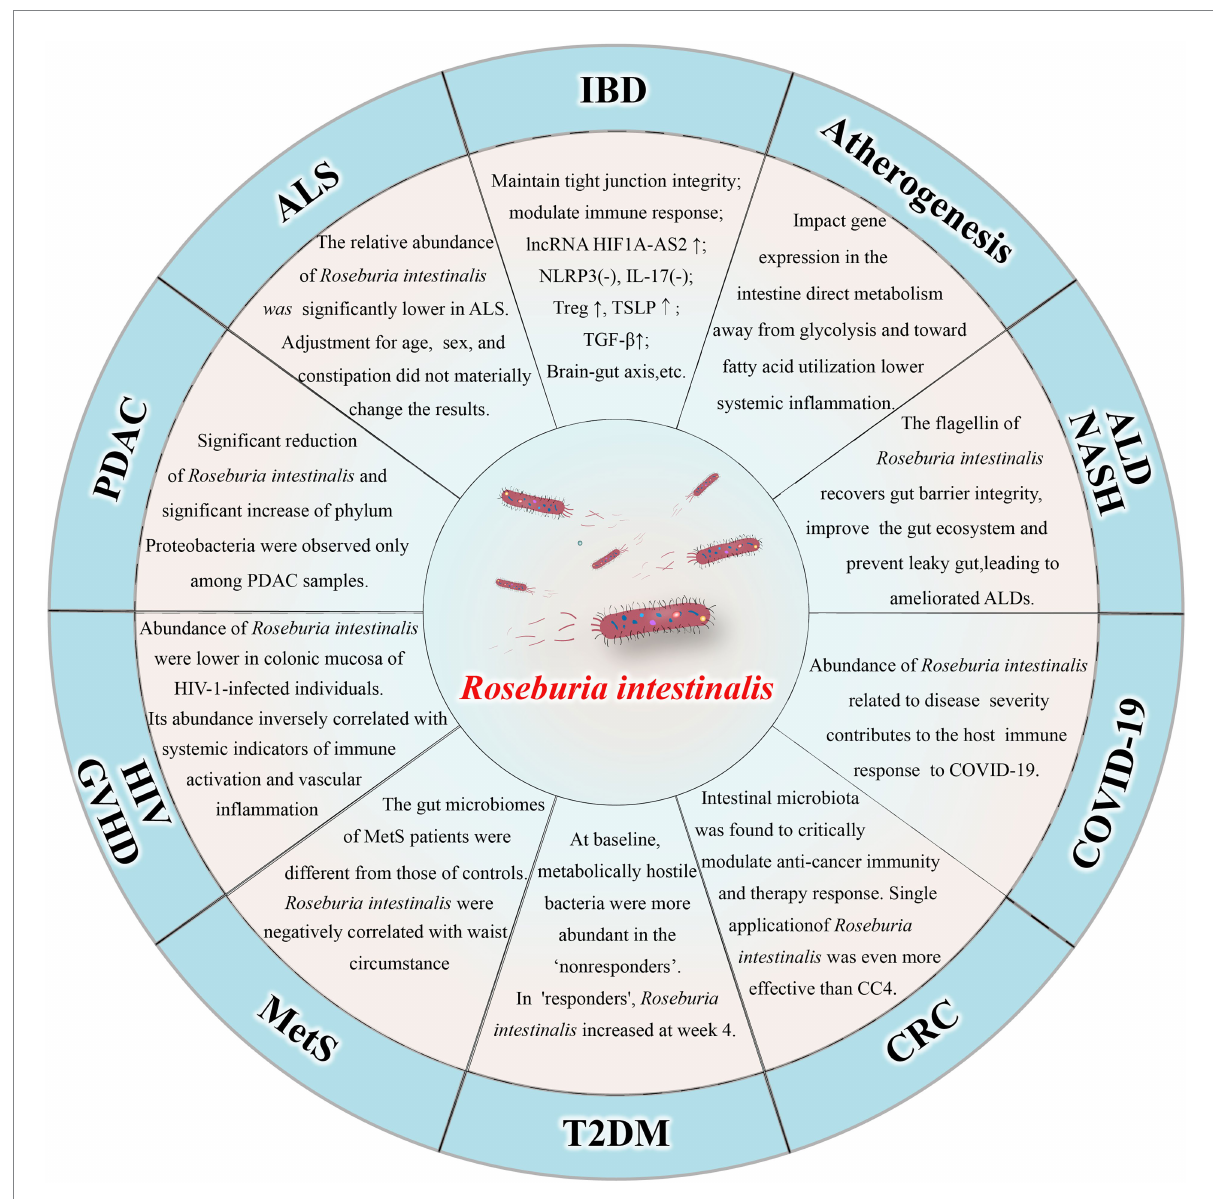
FIGURE 1 Relationship between Roseburia intestinalis and various diseases. IBD: inflammatory bowel disease; ALD: alcohol-related liver diseases; NASH: nonalcoholic steatohepatitis; COVID-19: coronavirus disease 2019; CRC: colorectal cancer; T2DM: type 2 diabetes mellitus; MetS: metabolic syndrome; HIV: human immunodeficiency virus; GVHD: Graft-versus-host disease; PDAC: pancreatic ductal adenocarcinoma; ALS: amyotrophic lateral